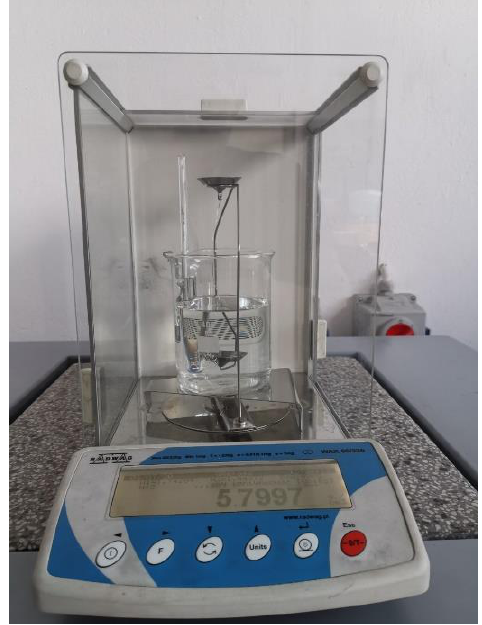
Figure 5. View of an analytical balance for density of the deposited layer measurement.